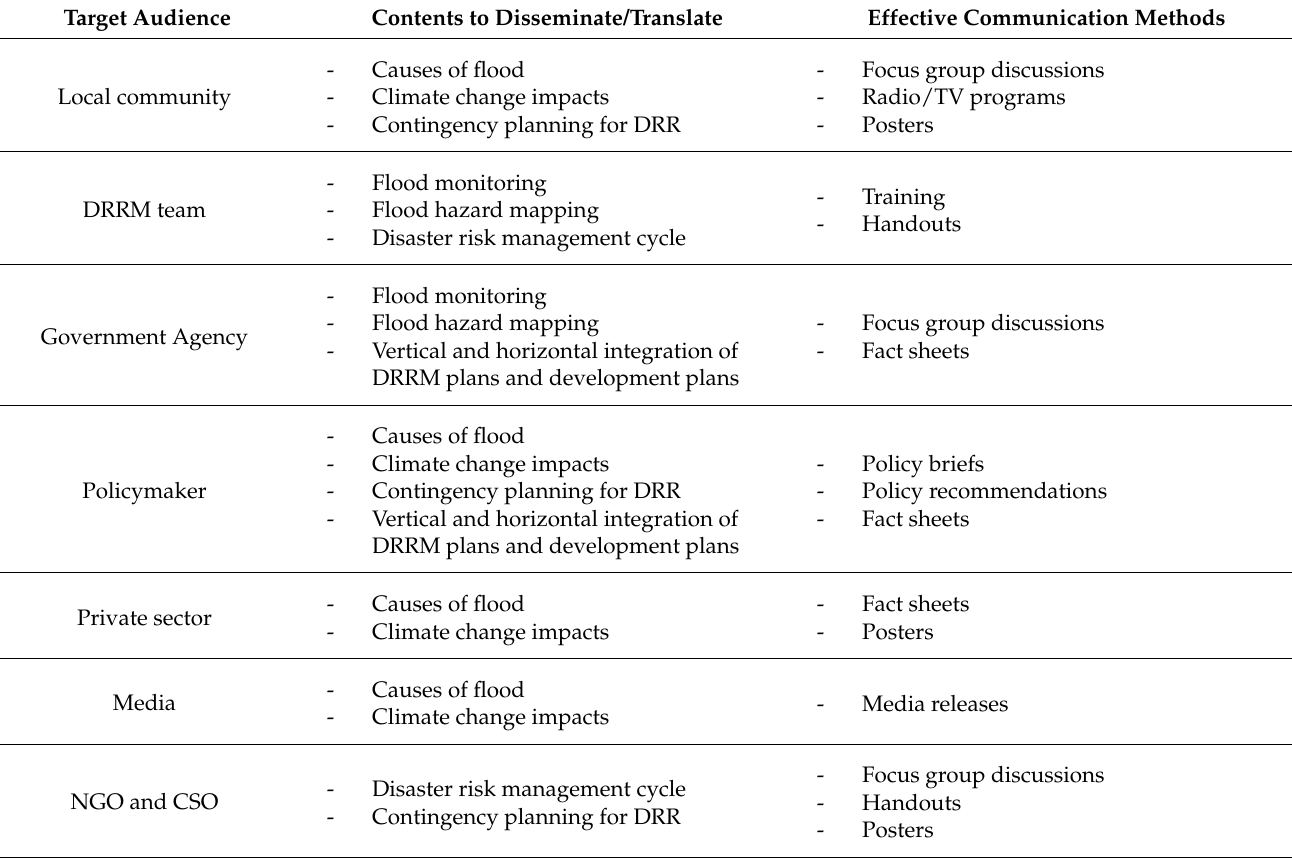
Table 4. Contents and methods of science communication with local society. Knowledge learned from OSS-SR and e-learning workshops is disseminated and translated in different ways according to the target